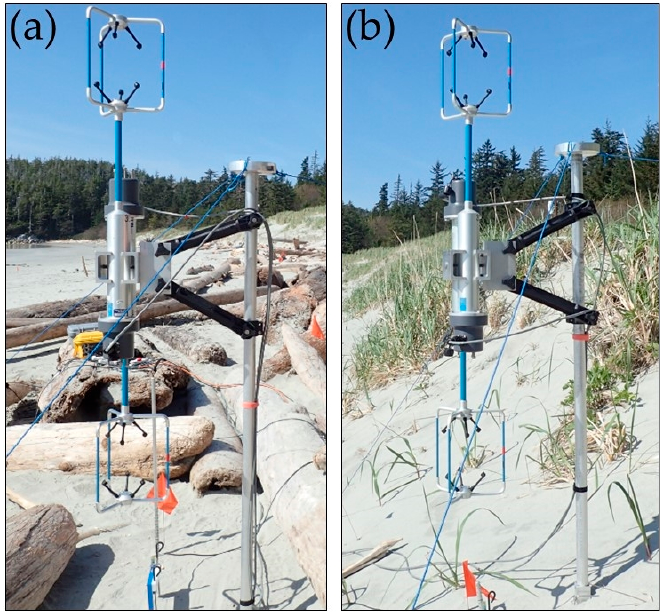
Figure 8. Deployment of 3D anemometer flow measurement stations on T1 in the LWD on the beach ( a ) and dune ( b ), approximately 7.5 m apart. The upper anemometer is set at 1.5 m and the lower at 0.5 m.